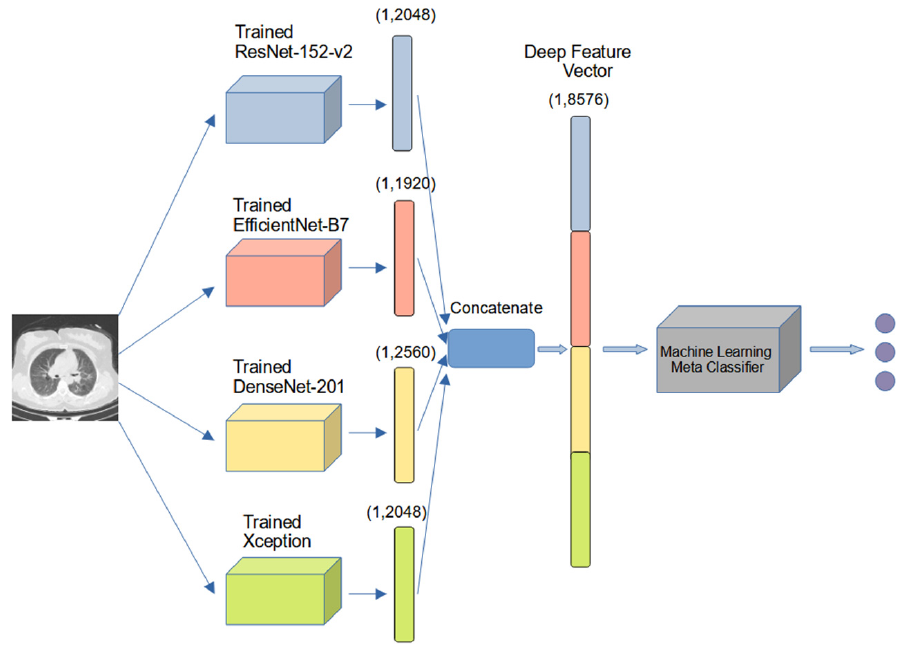
Figure 9. Shallow Meta-Learning Ensemble CNN Model.